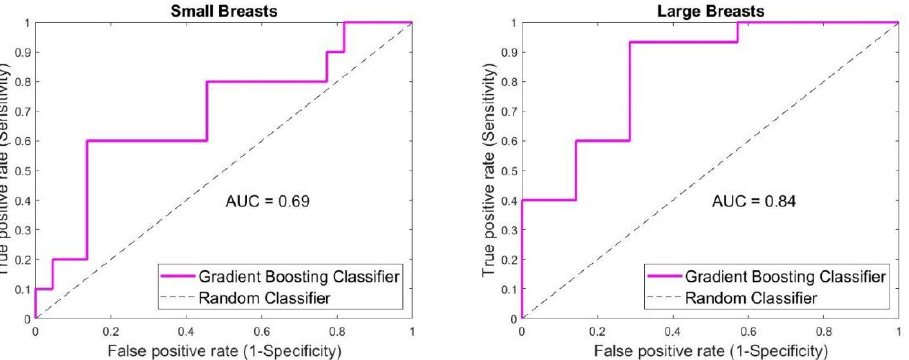
Figure 4. SAFE classification outcome based on the patient’s breast size. Device sensitivity and specificity were affected by the breast size, whereas lower sensitivity of 60% was noticed in smaller breasts compared to the 93% acquired in larger breasts. Contrary higher specificity of 86% was achieved in smaller breasts compared to the specificity of 71% in larger breasts. Higher accuracy was noticed in larger breasts (86% vs. 78%).